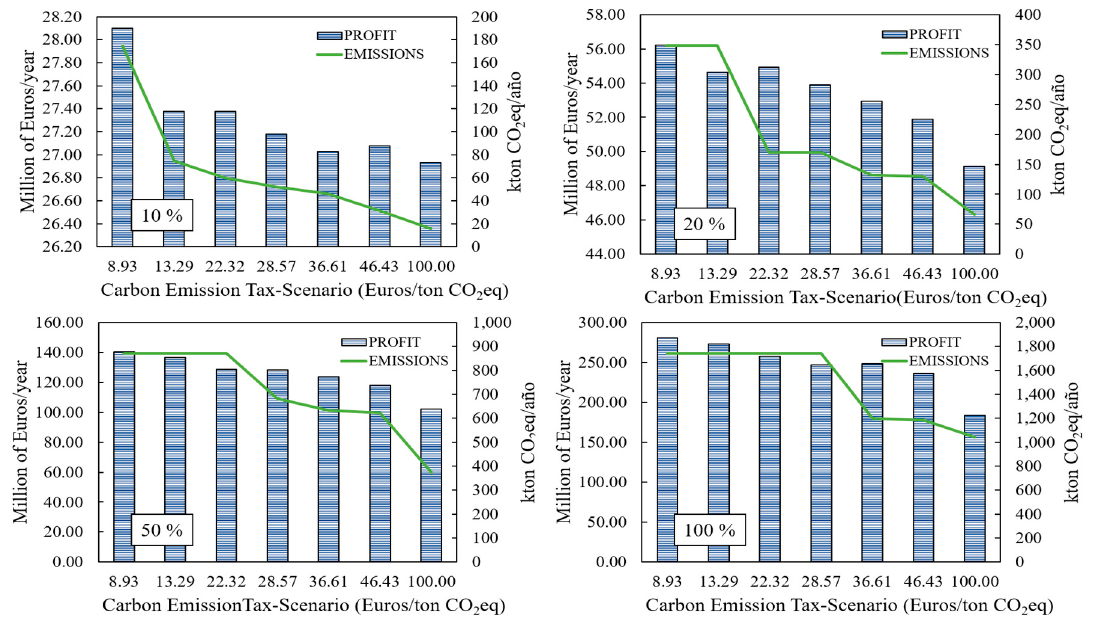
Figure 6. Results for carbon - emission tax scheme using the scenarios from Table 1 to satisfy 10%, 20%, 50% and 100% of energy demand (Case 1).